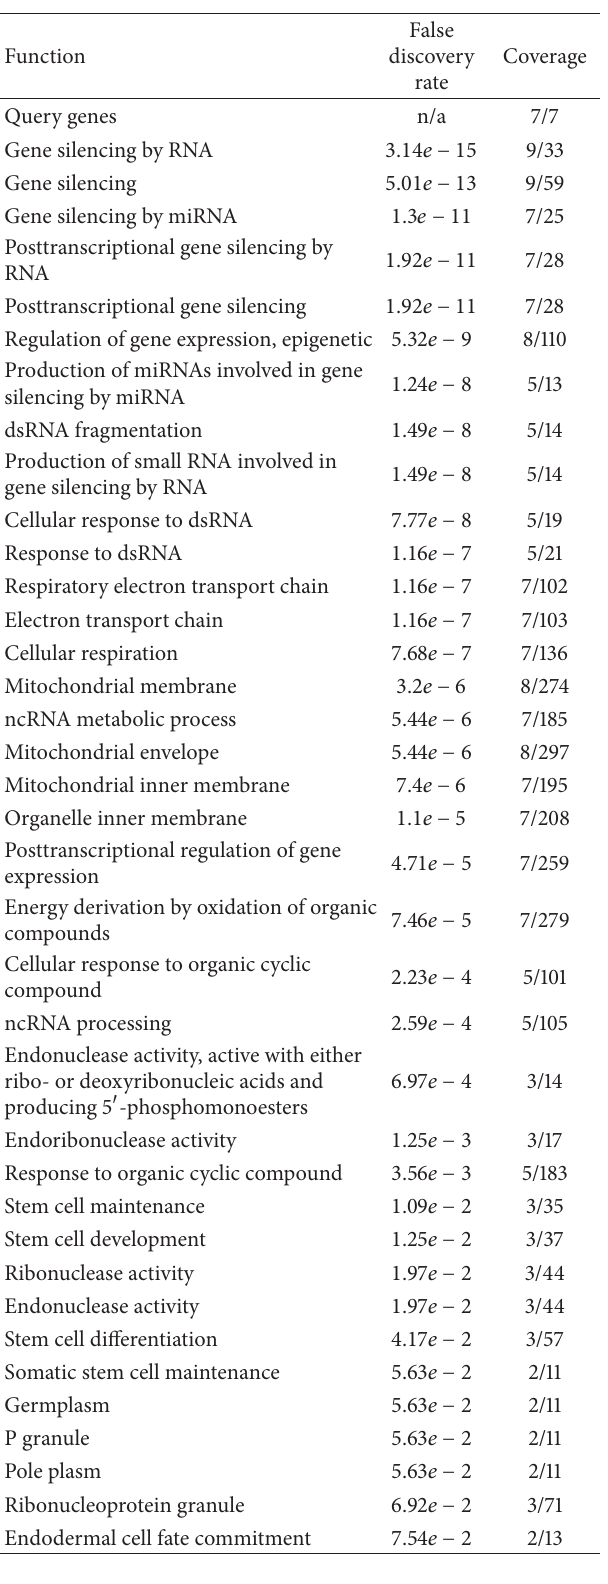
Table 3: Gene ontology of SOX2 ceRNA network by